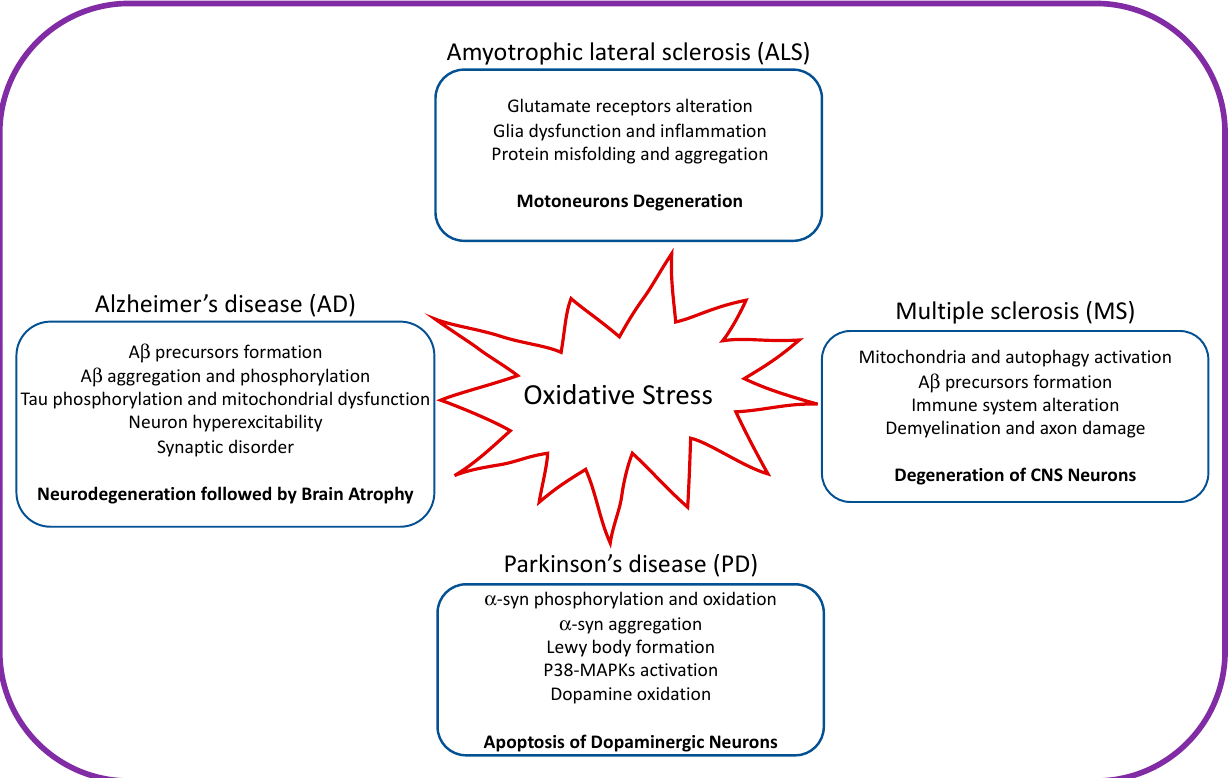
Figure 2. Illustration showing the impact of oxidative stress on amyotrophic lateral sclerosis, Alzheimer’s disease, Parkinson’s disease, and multiple sclerosis .